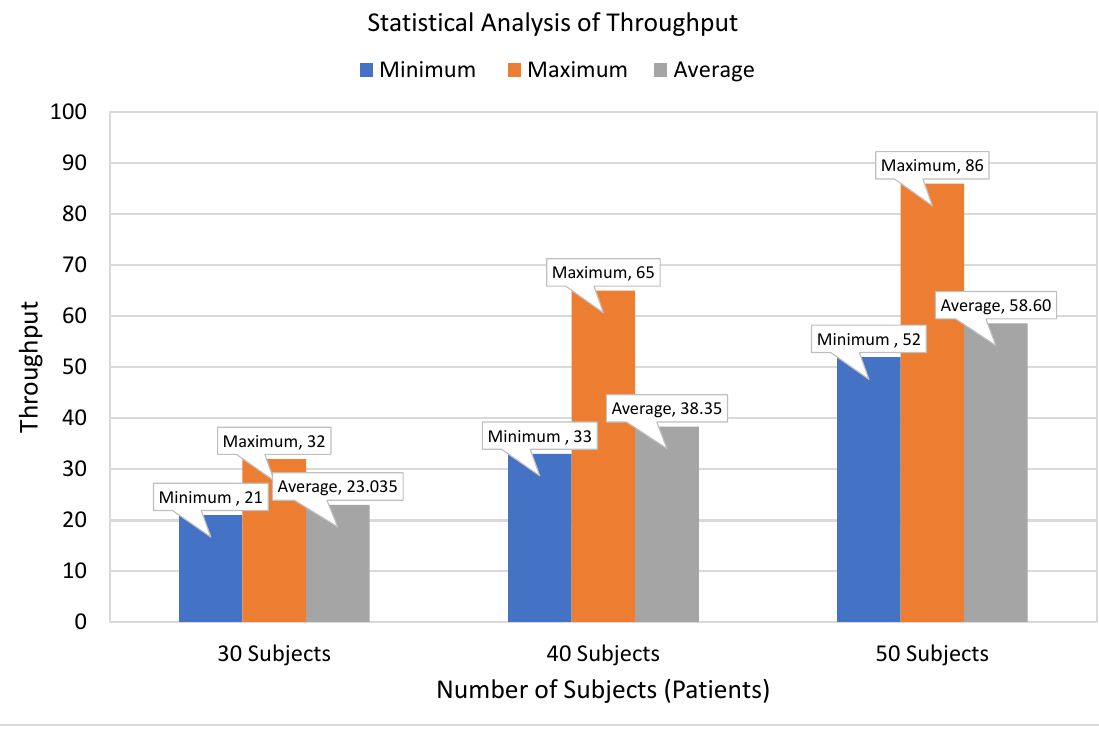
Figure 8. Statistical analysis of healthcare executed tasks per